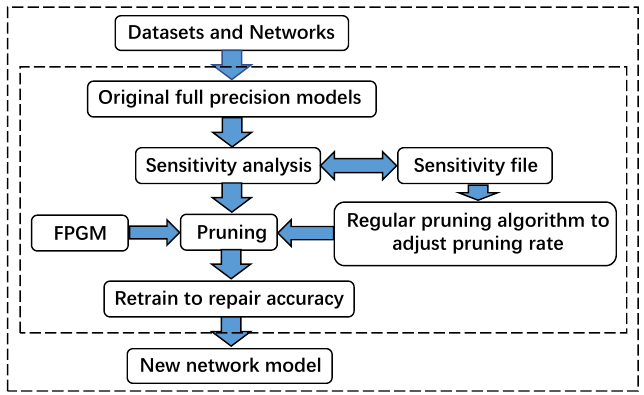
Figure 5. The implementation process of the pruning algorithm in this paper.